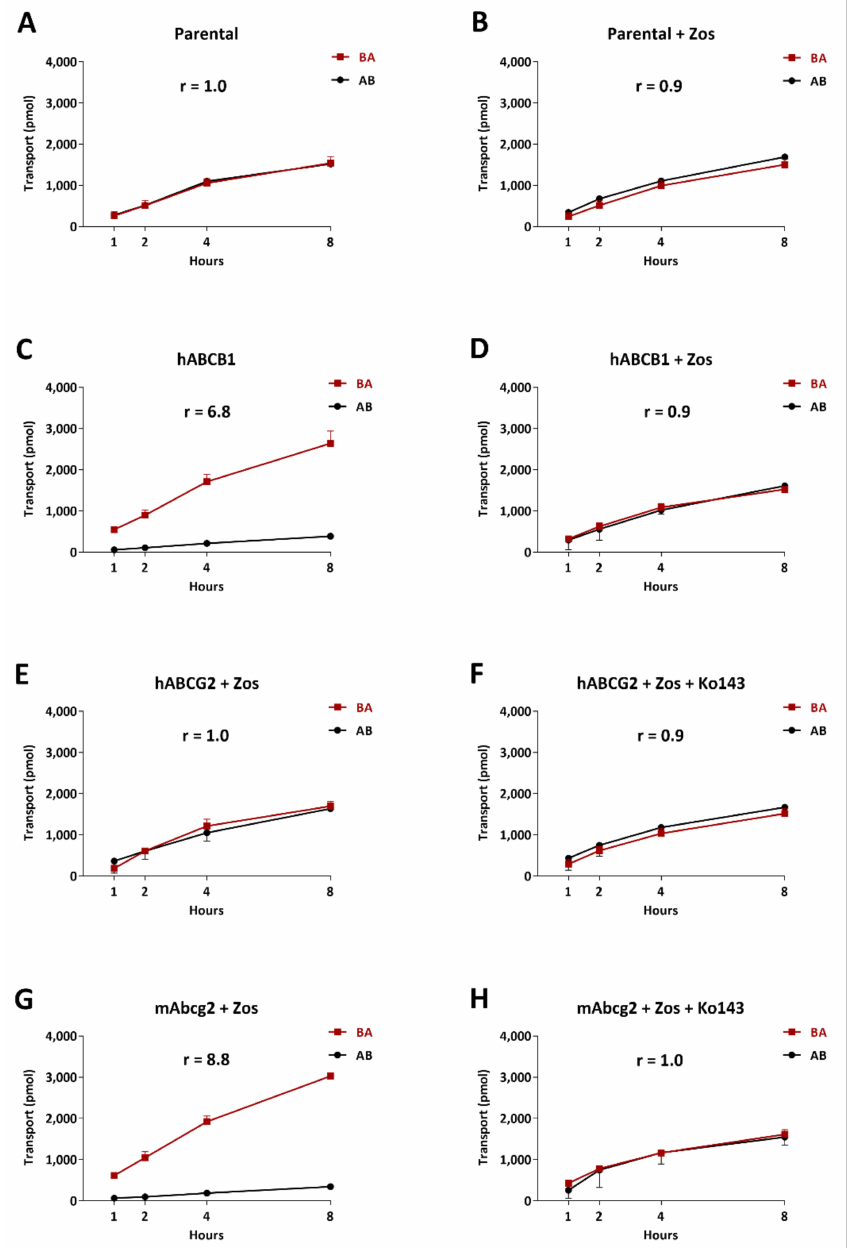
Figure 1. Transepithelial transport of selpercatinib (5 µ M) assessed in MDCK-II cells either nontrans- duced ( A , B ), transduced with hABCB1 ( C , D ), hABCG2 ( E , F ) or mAbcg2 ( G , H ) cDNA. At t = 0 h, drug was applied in the donor compartment and the concentrations in the acceptor compartment at t = 1, 2, 4 and 8 h were measured and plotted as cumulative amount of selpercatinib transported per well (pmol) in the graphs (n = 3). ( B , D – H ): Zosuquidar (Zos, 5 µ M) was applied to inhibit human and/or endogenous canine ABCB1. ( F , H ): the ABCG2 inhibitor Ko143 (5 µ M) was applied to inhibit ABCG2/Abcg2-mediated transport. r , relative transport ratio. AB ( • ), translocation from the apical to the basolateral compartment; BA ( (cid:4) ), translocation from the basolateral to the apical compartment. Points, mean; bars,